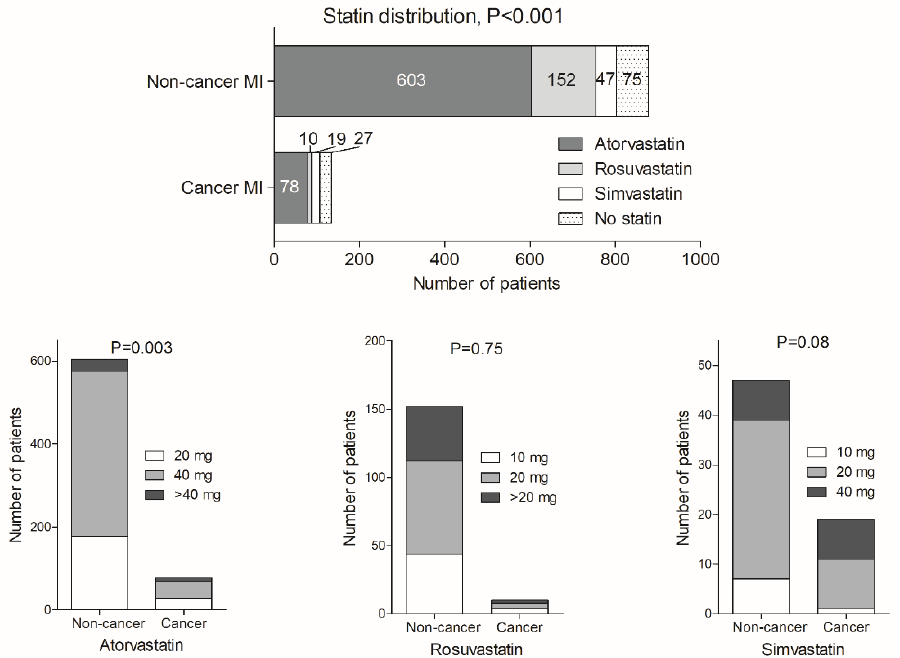
Figure 1. Statins’ distribution and their doses in myocardial infarction patients with and without cancer. Abbreviations: MI: myocardial infarction, p -value for differences between cancer and non- cancer patients. Table 3. The multivariable logistic regression of no statin use.